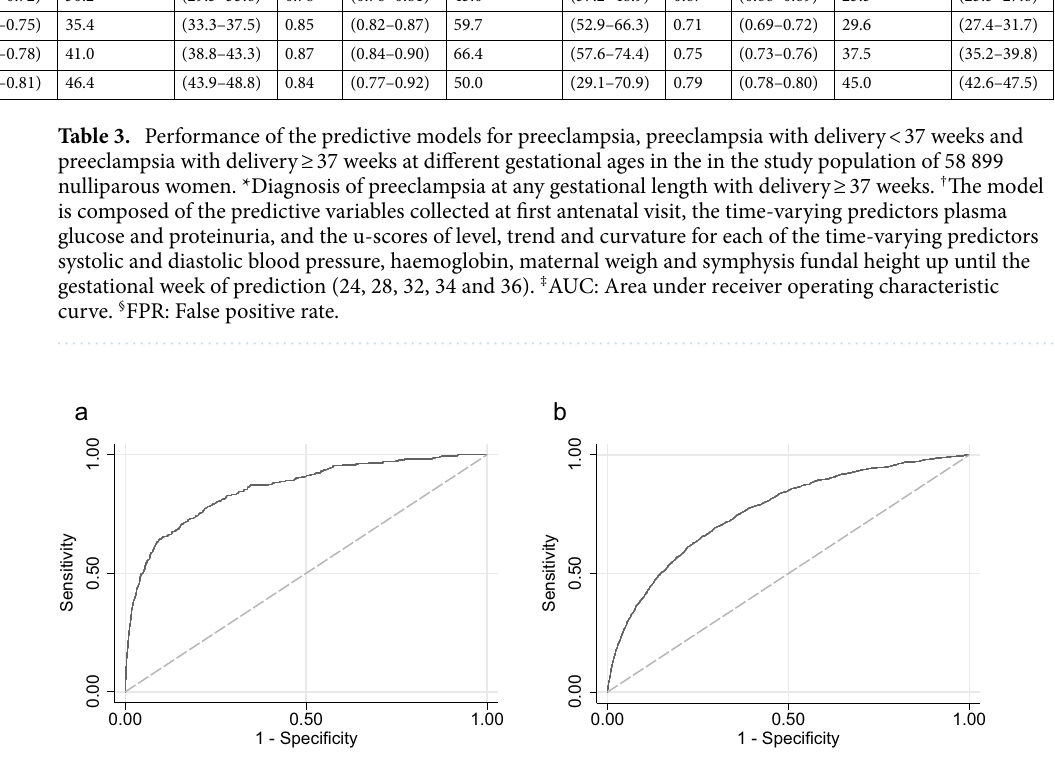
Figure 2. ROC curves for prediction of ( a ) preterm preeclampsia at 34 weeks’ gestation and ( b ) prediction of term preeclampsia at 36 weeks’